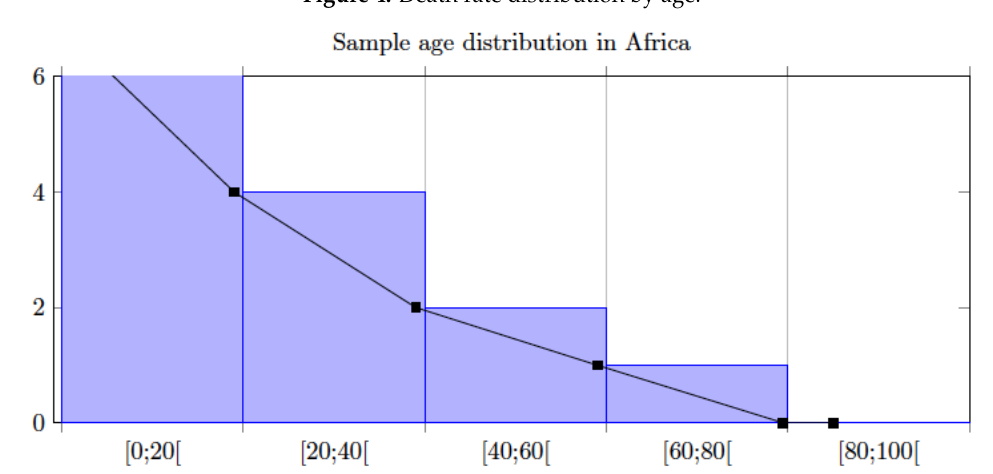
Figure 4. Death rate distribution by age.